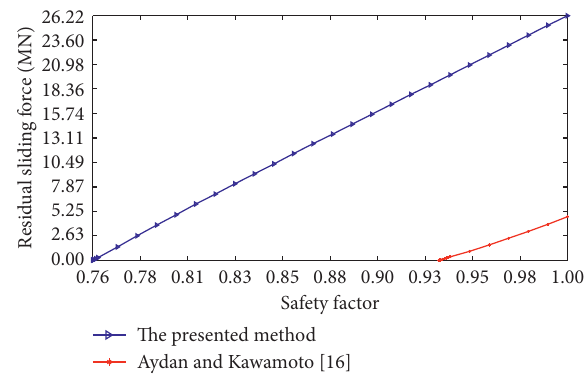
Figure 7: Convergence curves of the safety factor of stability of the slate slope in South Anhui in China obtained using different